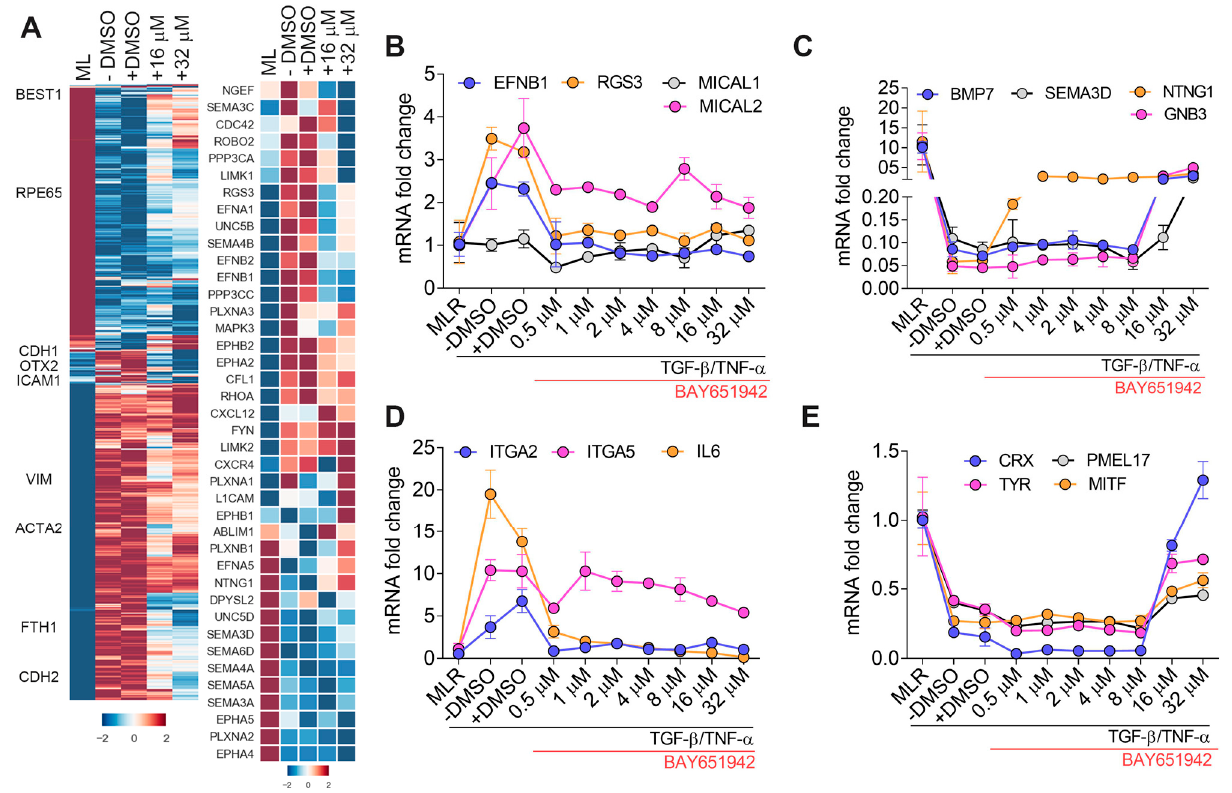
Figure 2. Transcriptomic analysis of BAY651942 modulated RPE–EMT in TGF– β /TNF– α model. ( A ) Hierarchical clustered heatmaps of log2-transformed ratios. Average abundances of DEG showing significant differences from DMSO and BAY651942 treatment after TGF– β /TNF– α -induced EMT in hiPS–RPE. Heatmap of axon guidance genes that were altered by BAY651942 treatment compared TGF– β /TNF– α plus DMSO treatment. ( B – E ) qPCR validation of altered multiple axon guidance genes ( B – D ), RPE genes ( E ) by BAY651942 treatment followed by TGF– β /TNF– α -induced EMT. Error bars represent SD of at least three biological replicates and statistically significant mean differences ( p < 0.05 by